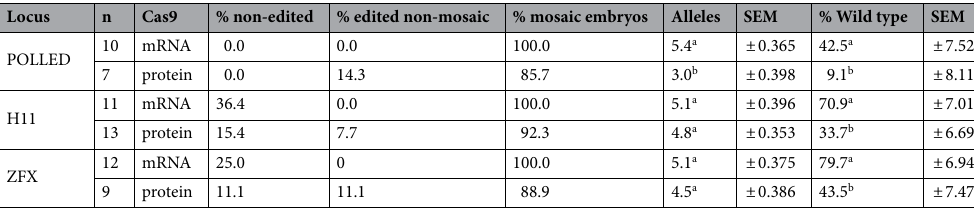
Table 2. Editing efficiencies, mosaicism, average number of alleles and percent wild type reads as determined by PacBio sequencing of 63 blastocysts following microinjection of Cas9 mRNA or protein alongside gRNAs targeting three loci (POLLED, H11, and ZFX) on different chromosomes. I n vitro fertilized bovine embryos were injected 18 h post insemination. Letters that differ in the same column are significantly different (P < 0.05). SEM = standard error of the